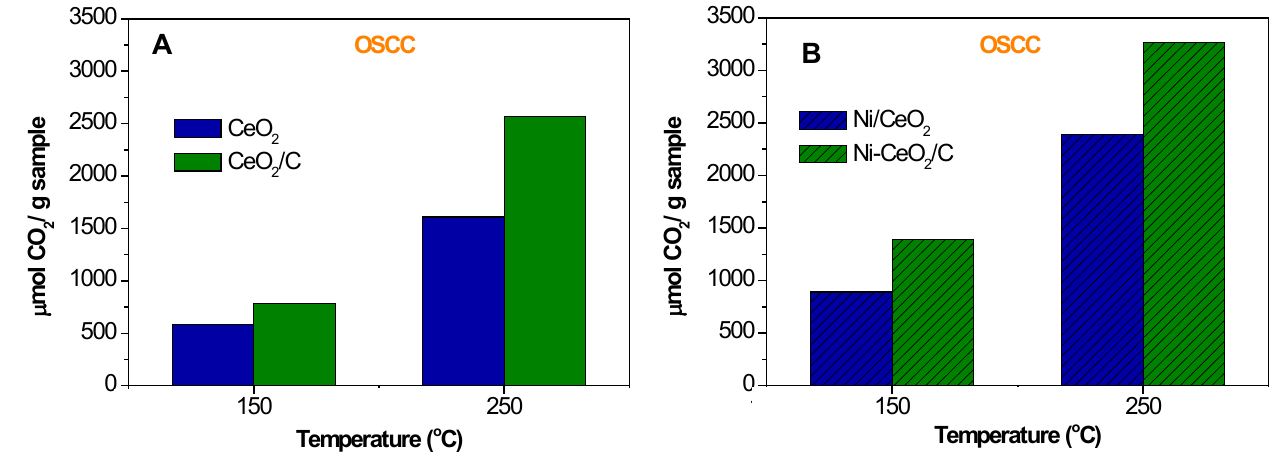
Figure 1. Oxygen storage complete capacity (OSCC) of the prepared solids. ( A ) supports ( B ) Ni based